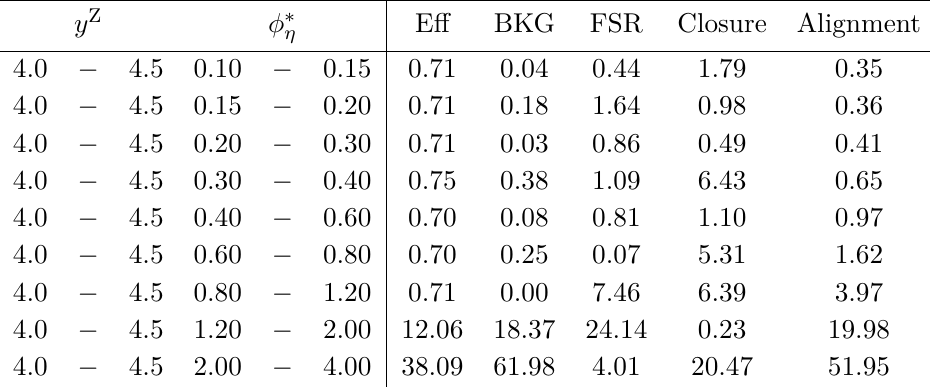
Table 23. Systematic uncertainties in the double differential cross-sections in interval regions of y Z and φ ∗ , presented in percentage. The contributions from efficiency (Eff), background (BKG), η final state radiation (FSR), closure test (Closure), and alignment and calibration (Alignment) are